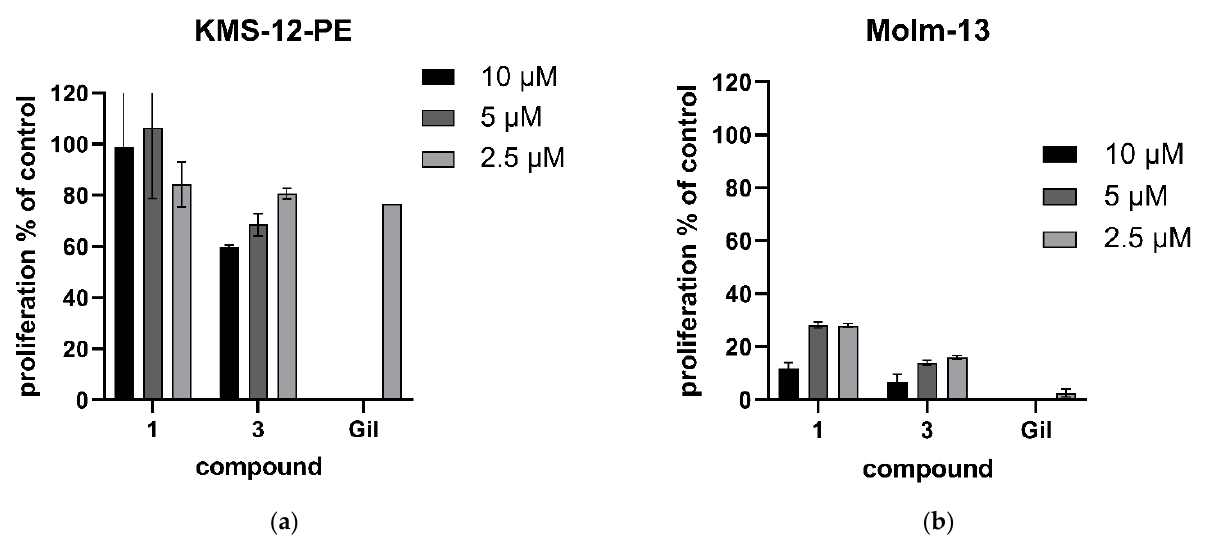
Figure 3. Proliferation of cancer cells after treatment with selected compounds. Percentage of proliferation after treatment with different compounds for 48 h was measured with a modified MTT assay. ( a ) KMS-12-PE and ( b ) Molm-13 cells were treated with indicated concentrations (10 µM/ 5 µM/ 2.5 µM) of compounds 1 and 3 and gilteritinib (2.5 µM) as positive control. Percentage of proliferation was calculated compared to untreated (set at 100%). Mean +/ − SD of 3 (AML) — 2 (MM) independent experiments are shown.